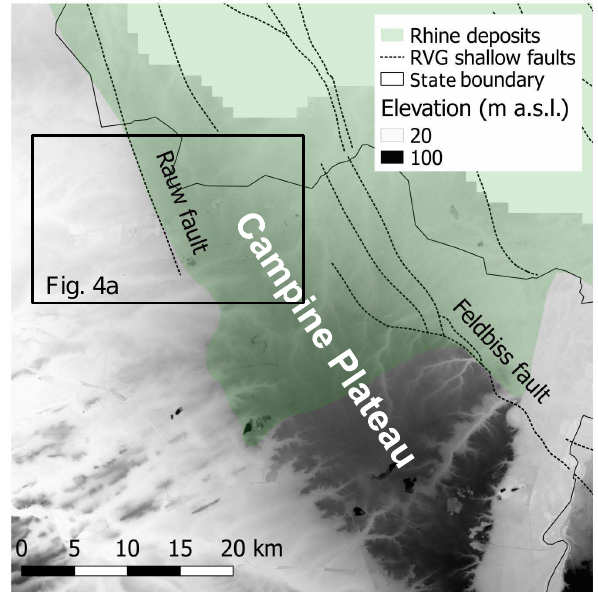
Figure 3. DTM of the Campine Plateau (Digitaal Hoogtemodel Vlaanderen II, DTM, raster, 1m) and the extent of Rhine deposits in the study area (shading based on Beerten, 2005, and Deckers et al.,